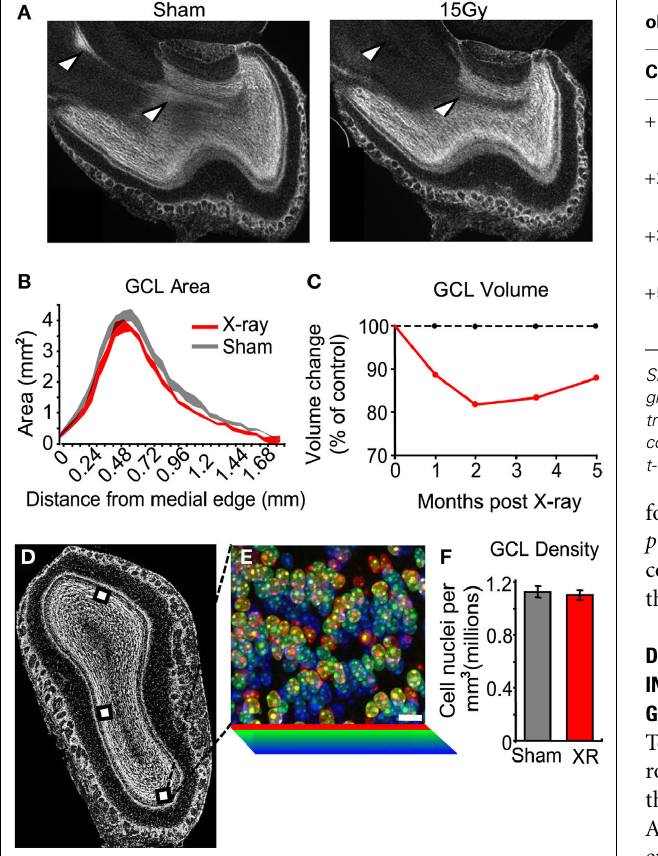
Table 1 | Reduction in volume of granule cell containing layers of the olfactory bulb granule cell layer after SVZ irradiation.